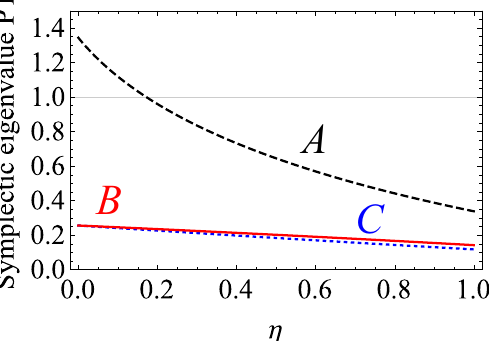
Figure 4. The dependence of smallest symplectic eigenvalues E ˆ E ˆ ( C ) on transmission loss η under the condition of G 1 = G 2 = G 3 = 2 and β = 1. A 2 − ˆ C 1 ˆ A 3